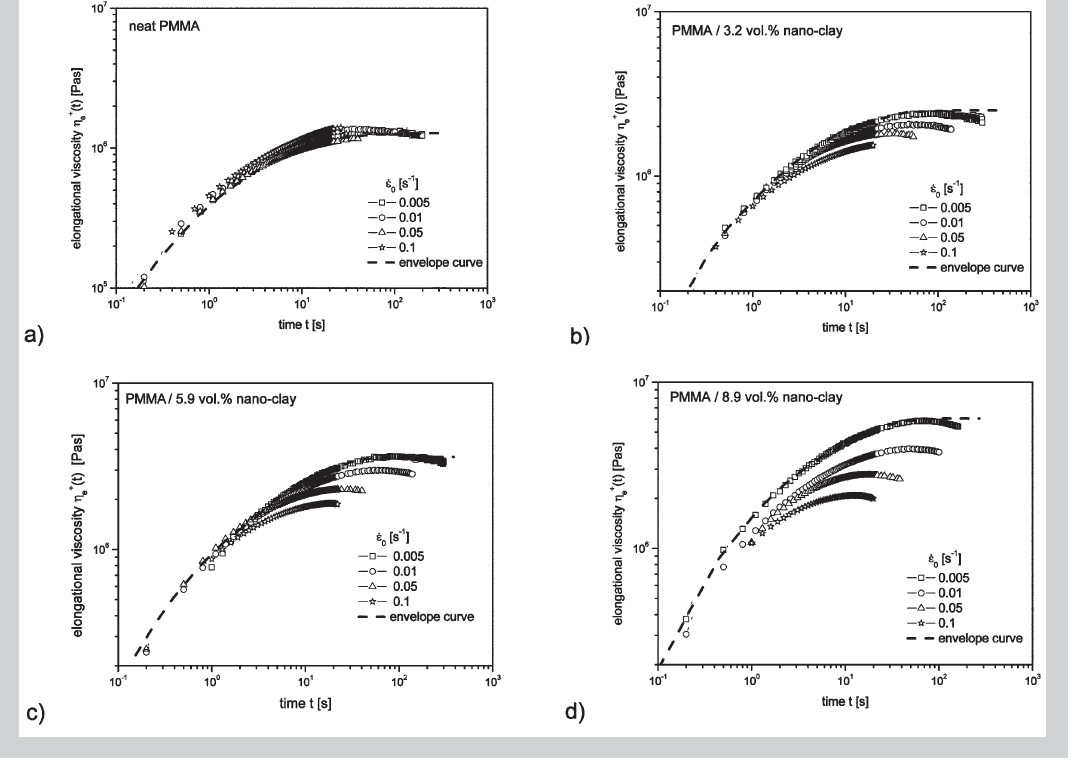
Figure 3: Transient elongational vis- cosity at 180°C of a) neat PMMA, b) PMMA / 3.2 vol% nano- clay, c) PMMA / 5.9 vol% nano- clay, d) PMMA / 8.9 vol% nano-